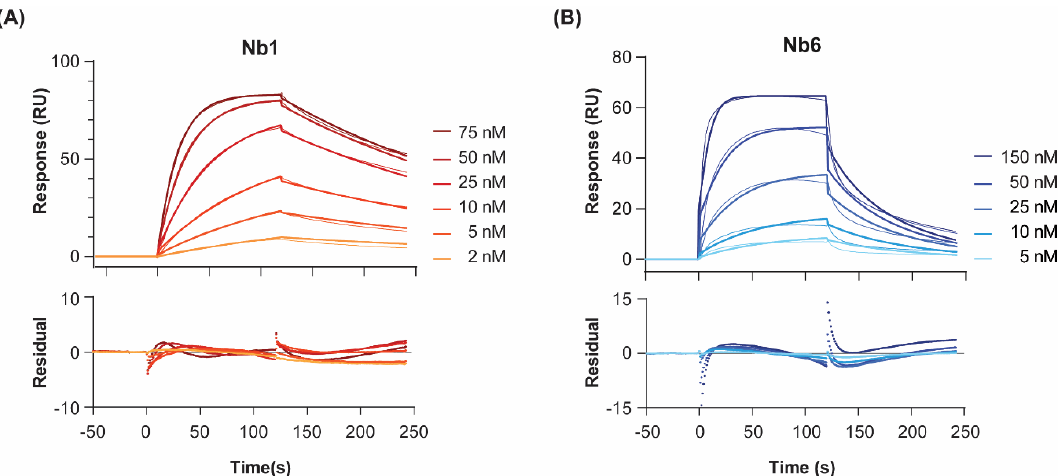
Figure 1. Binding kinetics of Nb1 ( A ) and Nb6 ( B ) to EGF at 25 °C. Nanobodies were injected at increasing concentrations over immobilised EGF, and the association and dissociation phases of all injections were fitted to a 1:1 Langmuir binding model. Two different surface densities were used for k on , k off and K D determination, with the corresponding background responses subtracted. Double-referenced sensorgrams for the highest density channel are shown here. Experiments were performed in duplicates. Residual errors from the fits are shown in the bottom panels.